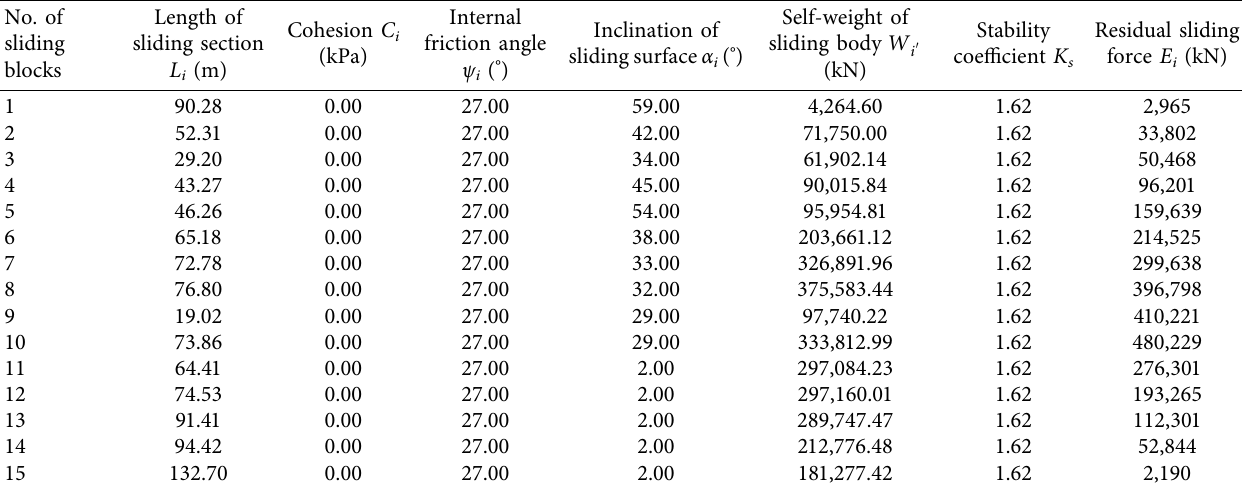
Table 10: Stability calculation for southern slope (case 2b: sliding surface of 6# coal